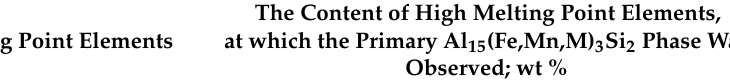
Table 4. Minimum content of high melting point elements, at which the primary ‘new’ intermetallic phases were observed.